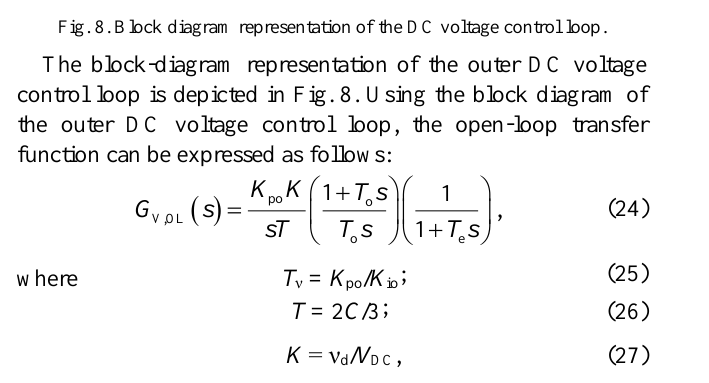
Fig. 9. Bode plot of the open-loop transfer function of the outer DC voltage control loop.